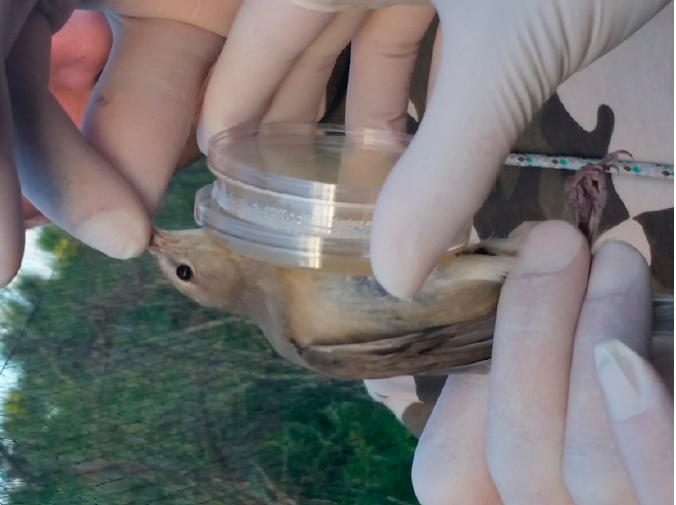
Figure 1. Swab sampling procedure (Ssp).